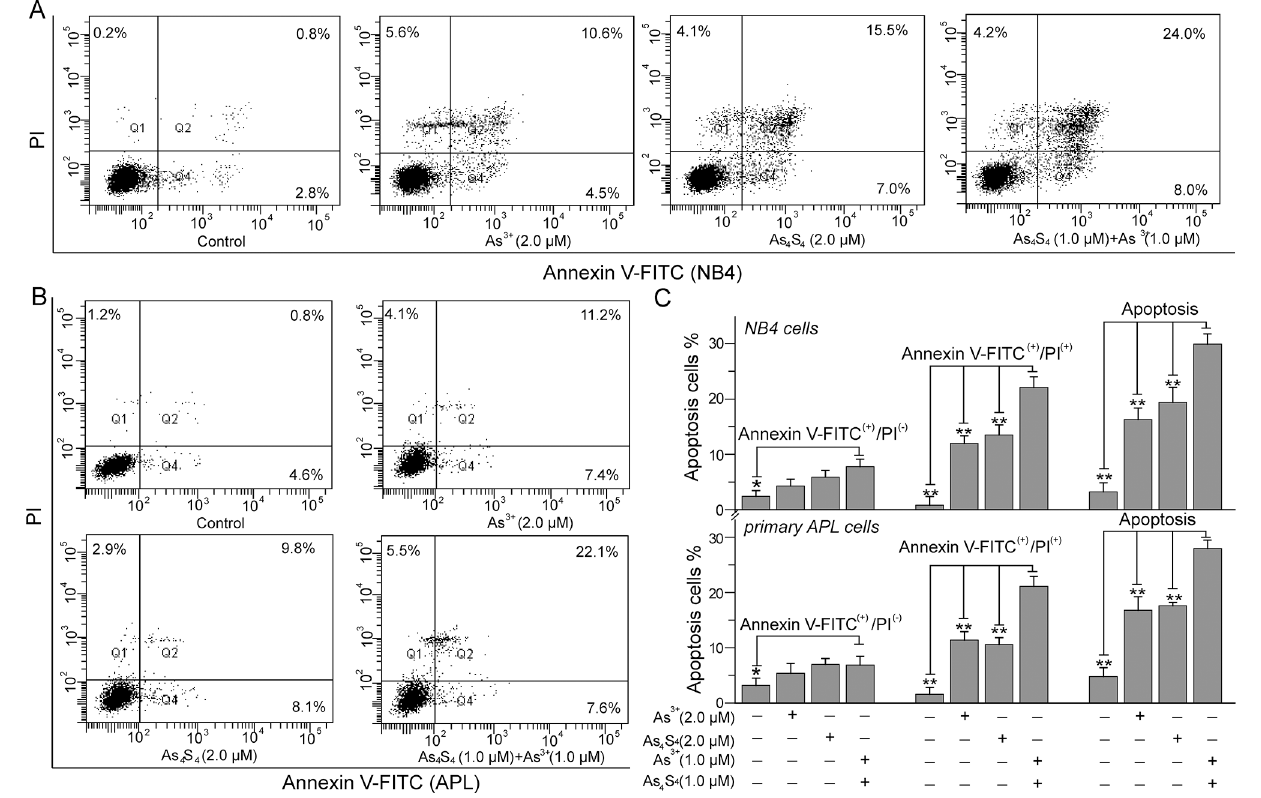
Fig 2. The effects of combining As 3+ and As 4 S 4 on the apoptosis of NB4 and primary APL cells. (A) The apoptosis of NB4 cells. (B) The apoptosis of primary APL cells. (C) The percentage of apoptotic cells in NB4 and primary APL cells. After 48 h of treatment, the cells were stained with Annexin V-FITC and PI. Q 1 and Q 3, represent the dead cells and living cells, respectively. Q 2 and Q 4 were used to calculate the proportion of apoptotic cells. Figures show a representative experiment of three independent experiments. * P < 0.05 and ** P < 0.01 compared with As 3+ and As 4 S 4 combination treated cells.